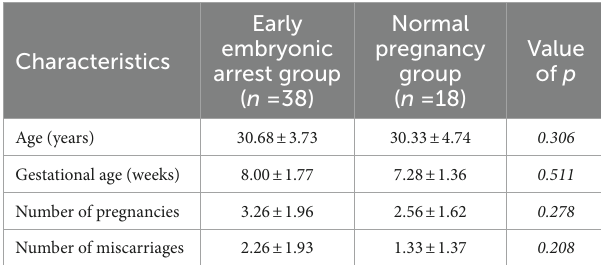
TABLE 1 General data of the 56 included women.